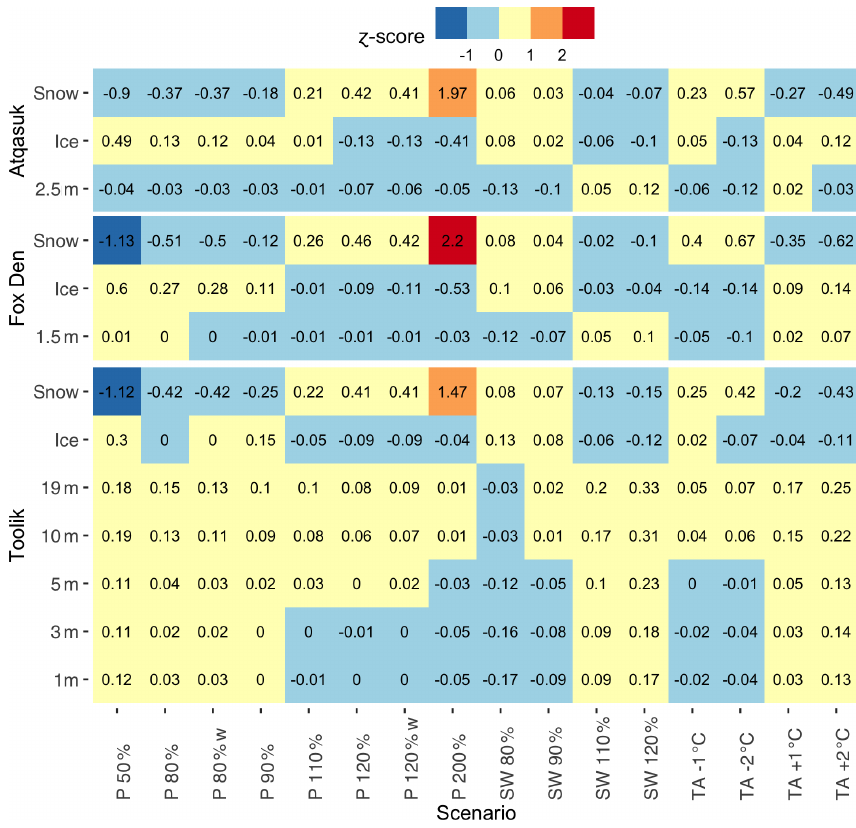
Figure 5. Model sensitivity matrix showing mean z -score for each scenario compared to the baseline model scenario for each response variable (ice thickness (m), snow depth (m), and water temperature at various depths). The sensitivity scenarios are precipitation (P, − 50%, − 20%, − 10%, + 10%, + 20%, + 100%), frozen precipitation (P w, − 20%, + 20%), shortwave radiation (SW, − 20%, − 10%, + 10%, + 20%), and air temperature (TA, − 2, − 1, + 1, + 2 ◦ C). Warm colors represent positive z -scores, while cool colors represent negative z - scores. Lighter colors indicate smaller z -scores, while darker colors indicate greater z